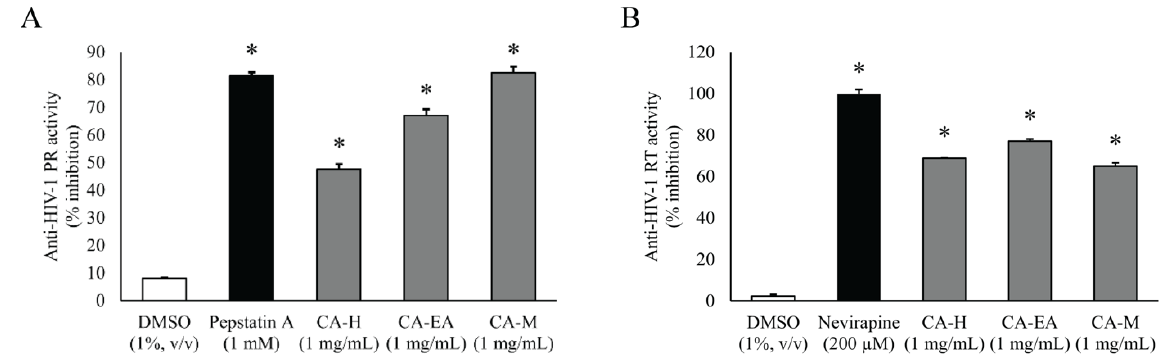
Figure 2. Inhibitory activities of CA extracts on HIV-1 PR ( A ) and HIV-1 RT ( B ). All extracts (1 mg/mL) significantly inhibited both HIV-1 PR and RT compared to DMSO control (One-way ANOVA, Dunnett’s test, * p < 0.05). Mean ± SD of at least three independent experiments is presented.